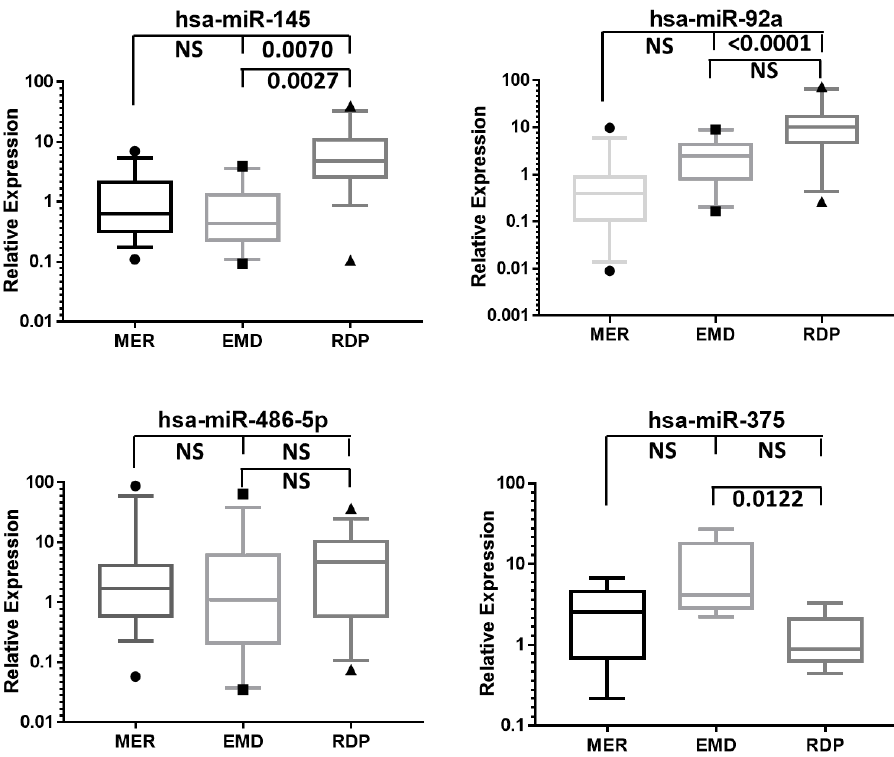
Figure 2. Relative expression of the four validated miRNAs in the serum. Four miRNAs were validated in all participants of the three study groups. p -values of the pairwise comparisons are shown (NS, not a significant p -value). The graph presents medians with an interquartile range. IEM, idiopathic epiretinal membrane. DME, diabetic macular edema. PDR, proliferative diabetic retinopathy.